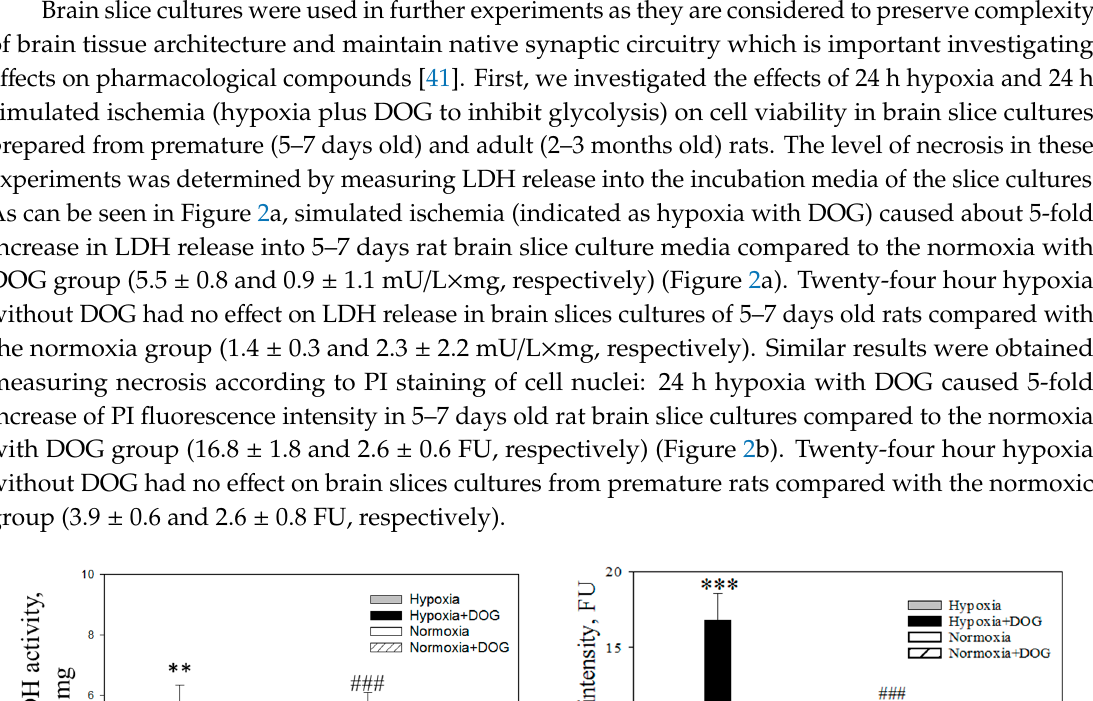
Figure 1. E ff ect of phenformin ( a ) and metformin ( b ) on neuronal viability in cerebellar granule cells (CGC) cultures. CGC were treated with phenformin and metformin at indicated concentrations. White column—viable neurons (%), black—necrosis (%), grey—apoptosis (%). The number of all neuronal cells (live, apoptotic and necrotic) in the vision field was equal to 100%. The data are presented as means ± standard errors of 3 experiments on separate CGC cultures.